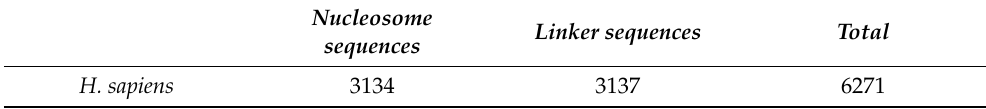
Table 3. The numbers of positive samples and negative samples in the DatasetNup_3